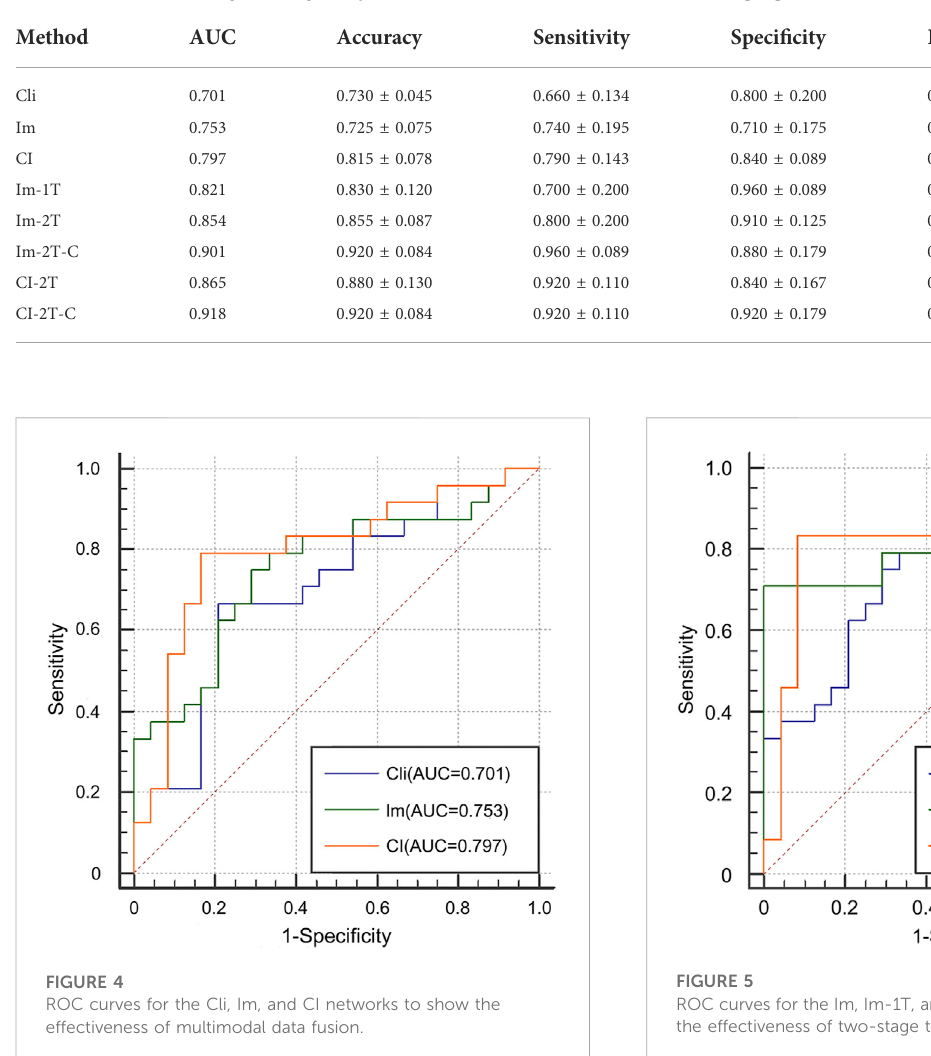
TABLE 2 Quantitative analysis of key components in our method. The best results are highlighted in bold.